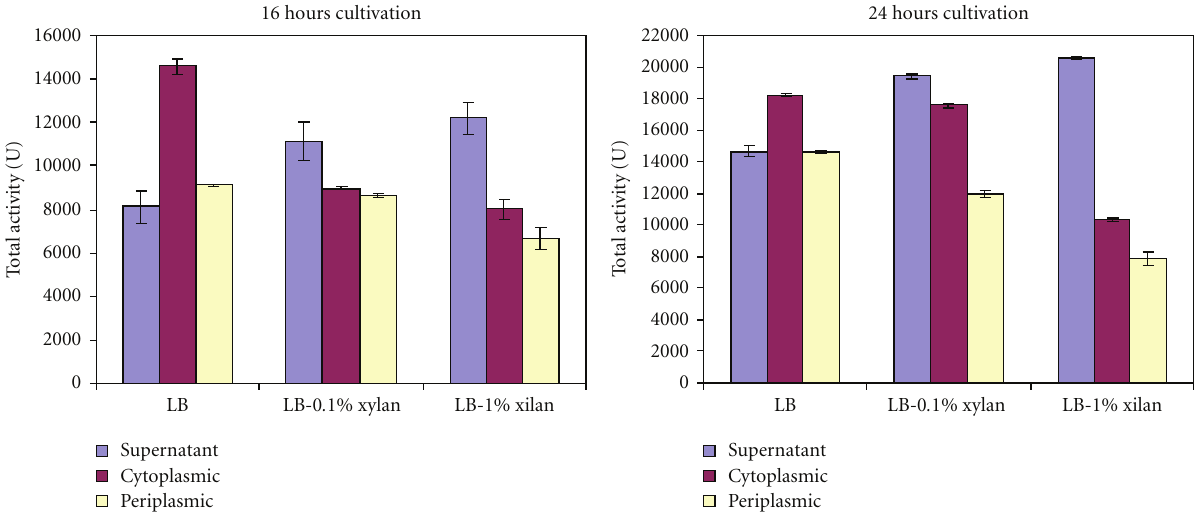
Figure 4: Recombinant AQ1 endoxylanase distribution in cellular compartment of E. coli after 16 and 24 hours of cultivation at 37 ◦ C of 25mL medium culture at shaking erlenmeyer flask. The given values in all activity assays are the means of triplicates, and the error bars indicate the standard deviation of these triplicates of independent